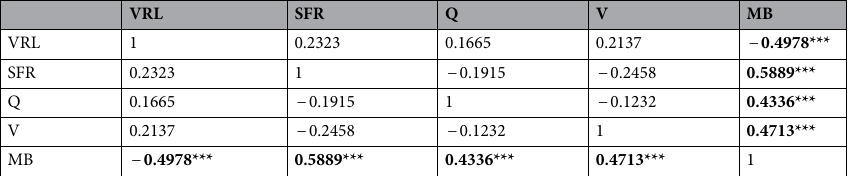
Table 1. Partial correlation coefficients of tested factors (***: p < 0.001). Bold values indicate moderate correlation. VRL venous reservoir level, SFR surgical field suction flow rate, Q blood perfusion flow, V blood viscosity, and MB: number of